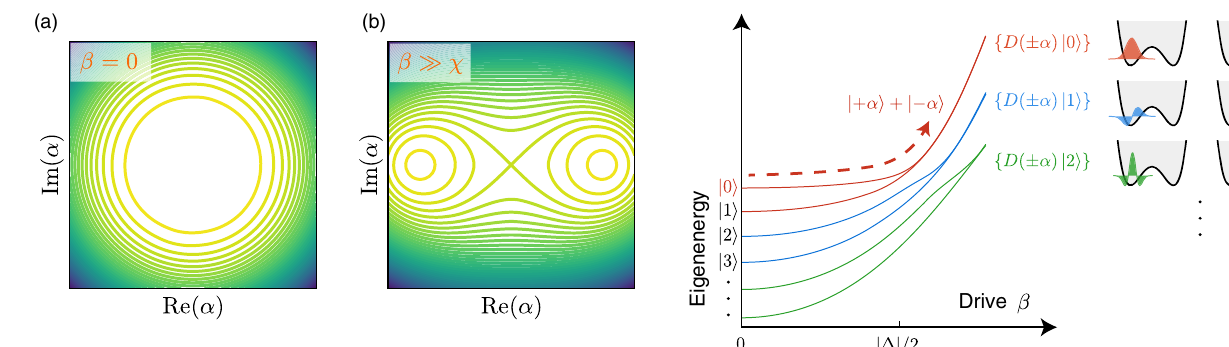
FIG. 7. Illustration of the effective potential V ð α Þ plot. (a) Po- tential at β ¼ 0 (below threshold) where there is only one global maximum. (b) The regime β ≫ χ (far above threshold) where the potential has two symmetrically placed local maxima.